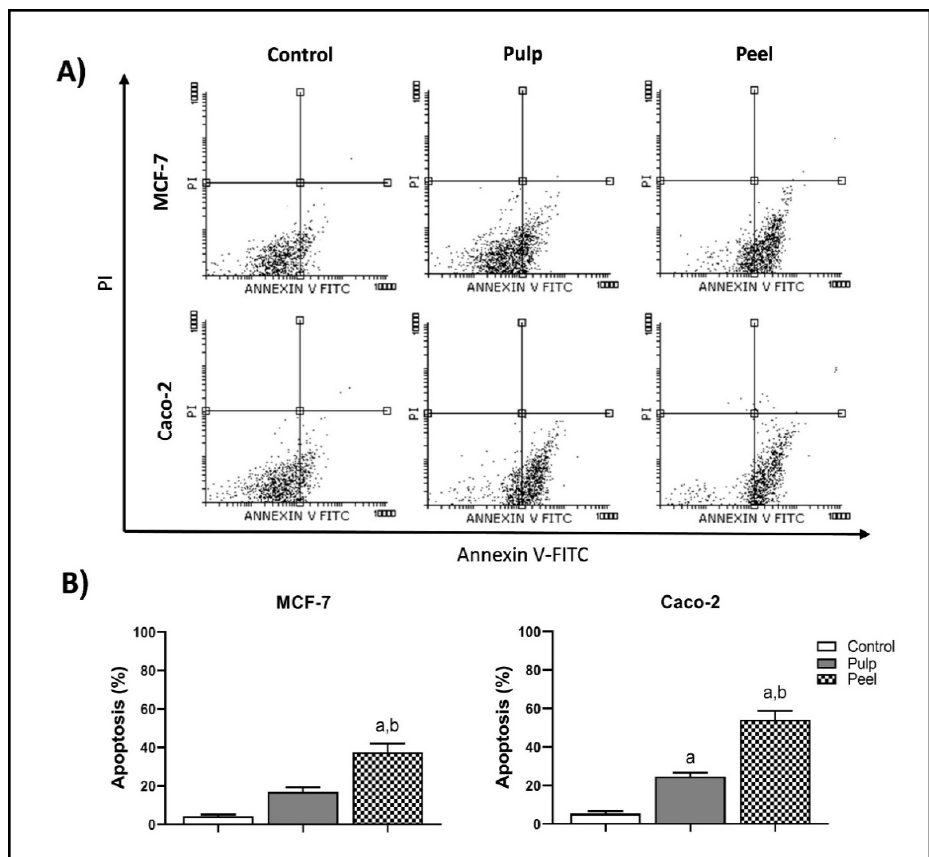
Figure 2. Flow cytometric analysis of apoptosis in MCF-7 and Caco-2 cells exposed to IC 50 of pulp and peel extracts of H. undatus for 48 h, stained with annexin-V/propidium iodide (PI) and analyzed for apoptosis using Flowing Software. ( A ) Representative scatter plots of PI vs. annexin-V. The viable cells (An − , PI − ) are shown in the lower left quadrants, while the early apoptotic cells (An + , PI − ) are shown in the lower right quadrants. The upper left quadrants contain the necrotic cells (An − , PI + ), while the upper right quadrants demonstrate the late apoptotic cells (An + , PI + ). ( B ) Apoptosis is quantified as the mean ± SEM of three independent experiments. a: p < 0.05, significantly different from the corresponding control group. b: p < 0.05, significantly different from the pulp extract-treated group. Multiple comparisons were accomplished using one-way ANOVA followed by Tukey–Kramer post hoc analysis .